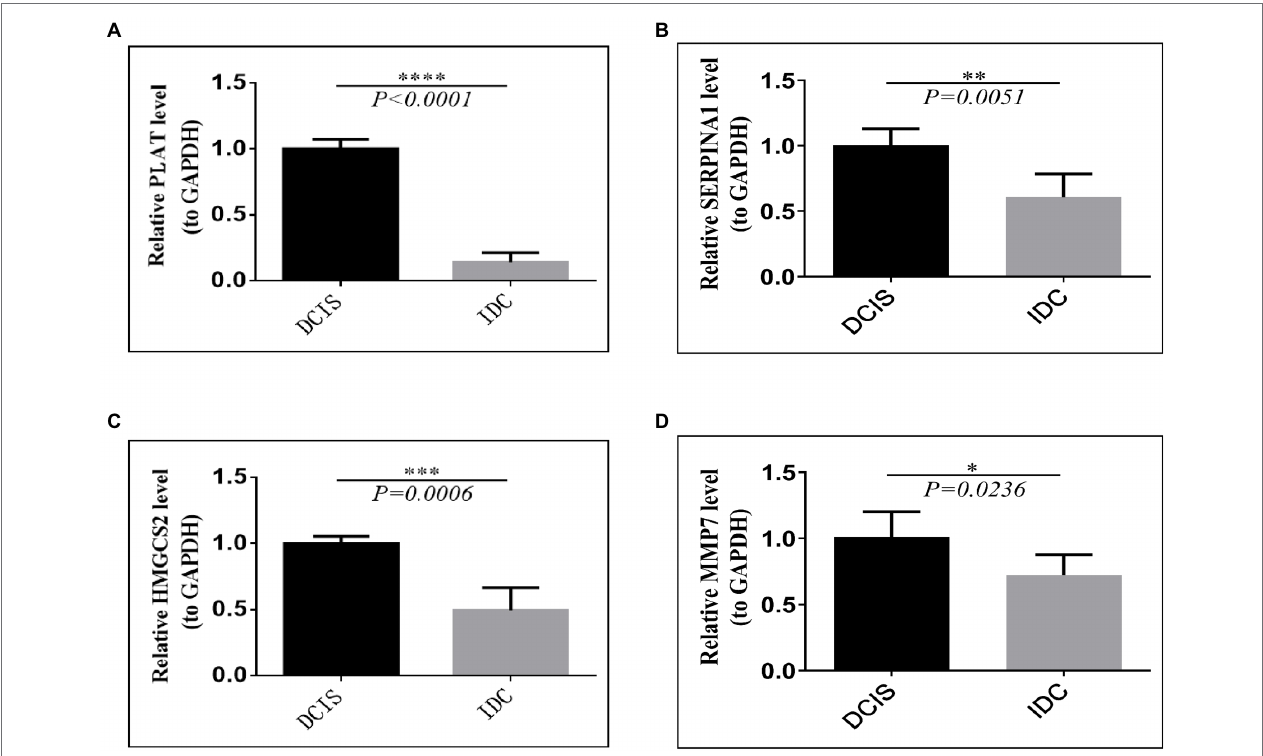
FIGURE 9 | Validation of prognostic signature gene expression in IDC/DCIS tissues. The mRNA expression patterns of four prognostic between DCIS and IDC tissues. (A) PLAT , (B) SERPINA1 , (C) HMGCS2, and (D) MMP7. All experimental data were expressed in means ± SD (IDC: n = 10, DCIS: n = 5). * p < 0.05, ** p < 0.01, *** p < 0.001, **** vs. the DCIS